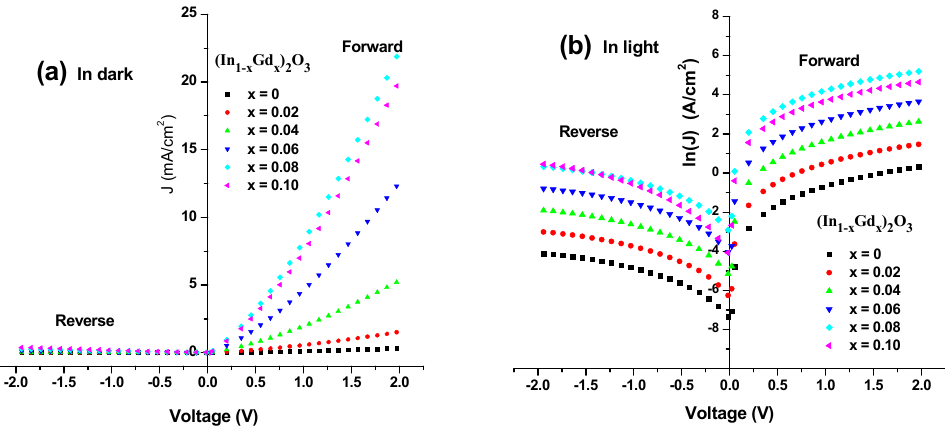
Figure 14. Current density, J versus voltage, V ( a ) in dark and ( b ) in light for n-(In 1 − x Gd x ) 2 O 3 films/p-Si substrate.